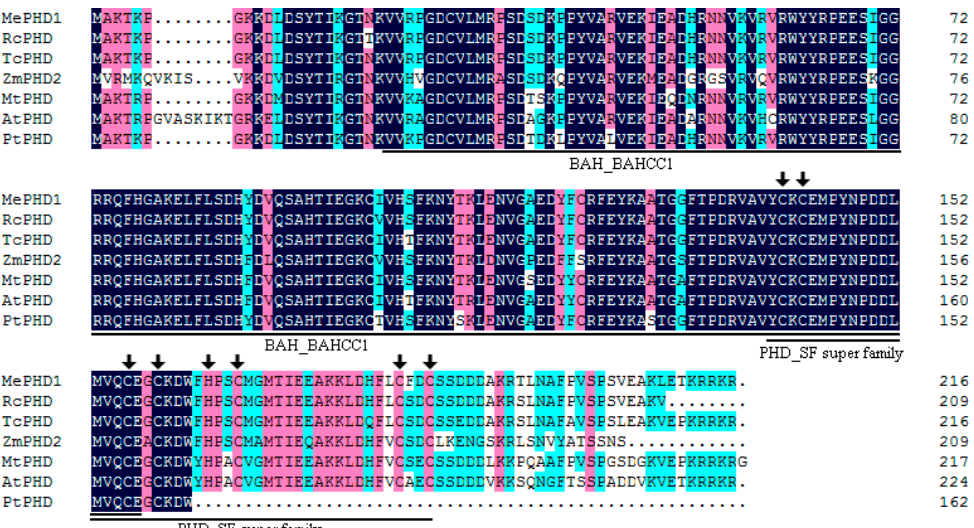
Figure 2. The PHD protein has one or several PHD-finger motifs, and a PHD-finger motif is composed of unique Cys4-His-Cys3 pattern zinc-containing domain. Amino acid sequences comparison of MePHD1 with related PHD proteins. Sequences were aligned by using DNAMAN6.0. Identical residues are highlighted in dark blue, and biochemically conserved substitutions are highlighted in two gradual darker colors (pink and cyan) according to identity. The conserved Cys4-His-Cys3 is indicated by the black arrow. Aligned sequences include MePHD1 (Manes.12G071000), RcPHD (B9SH49), TcPHD (XP_017969599), ZmPHD2 (NP_001131656), MtPHD (XP_013464613), AtPHD (NP_001031695), and PtPHD (G1FLG6).